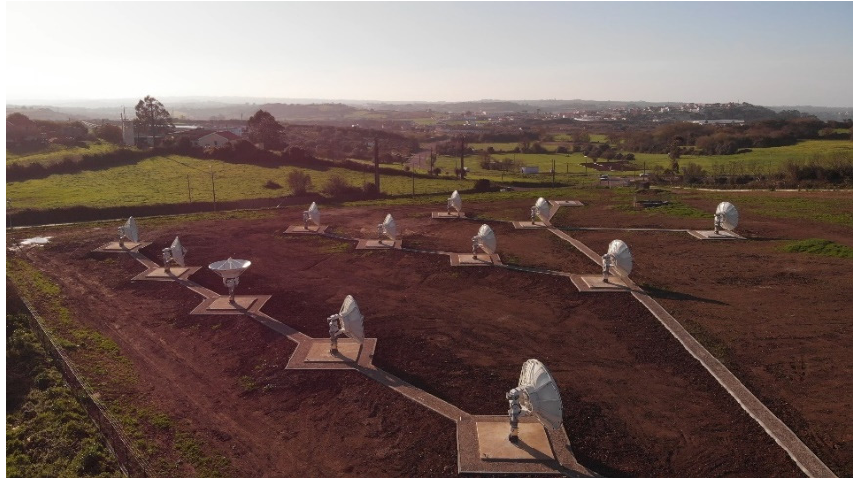
Figure 8. OneWeb SNP, Sintra, Portugal.